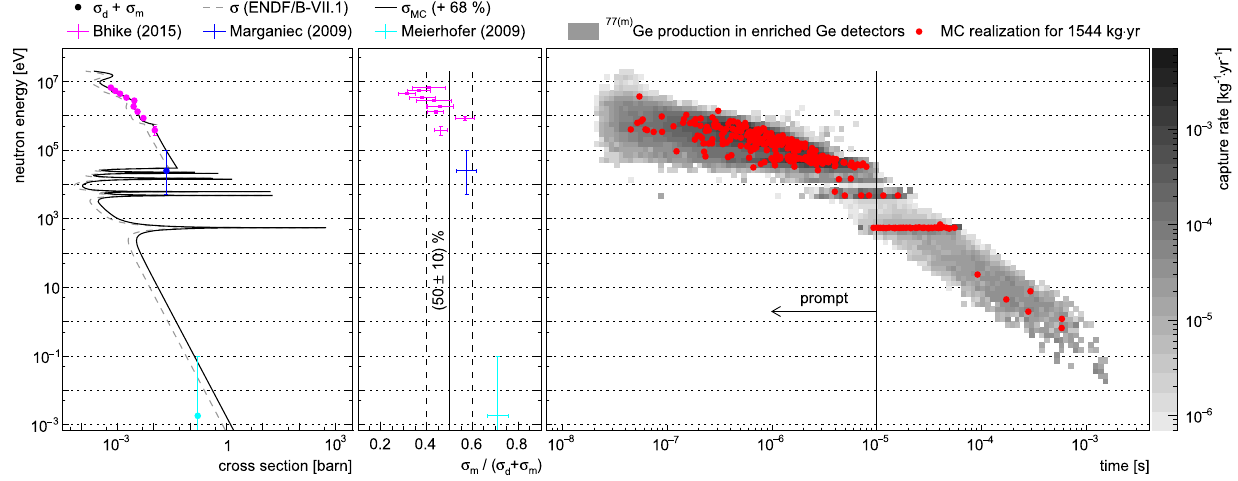
Fig. 4 Left: recent cross section data for 77 Ge and 77 m Ge production by neutron capture on 76 Ge. To account for full 77 m Ge production the cross section used in the simulation was increased by 68% compared to the plain ENDF-based one. Middle: ratio of σ m to total σ d + σ m cross section. An estimate of (50 ± 10)% was used in the analysis. The